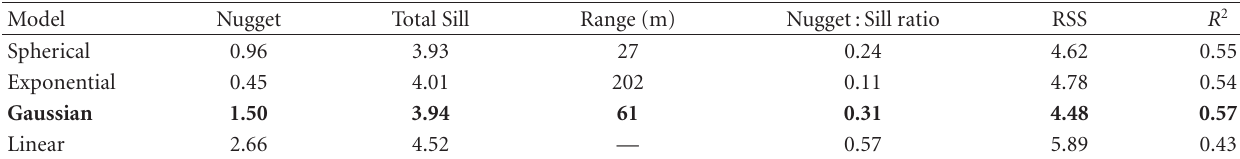
Table 8: Fitted semivariogram models nugget, total sill, range, nugget to sill ratio, residual sum of square (RSS), and R 2 value of EC 1:1 at 20–40 cm depth during 2009 (best fitted model is in bold).